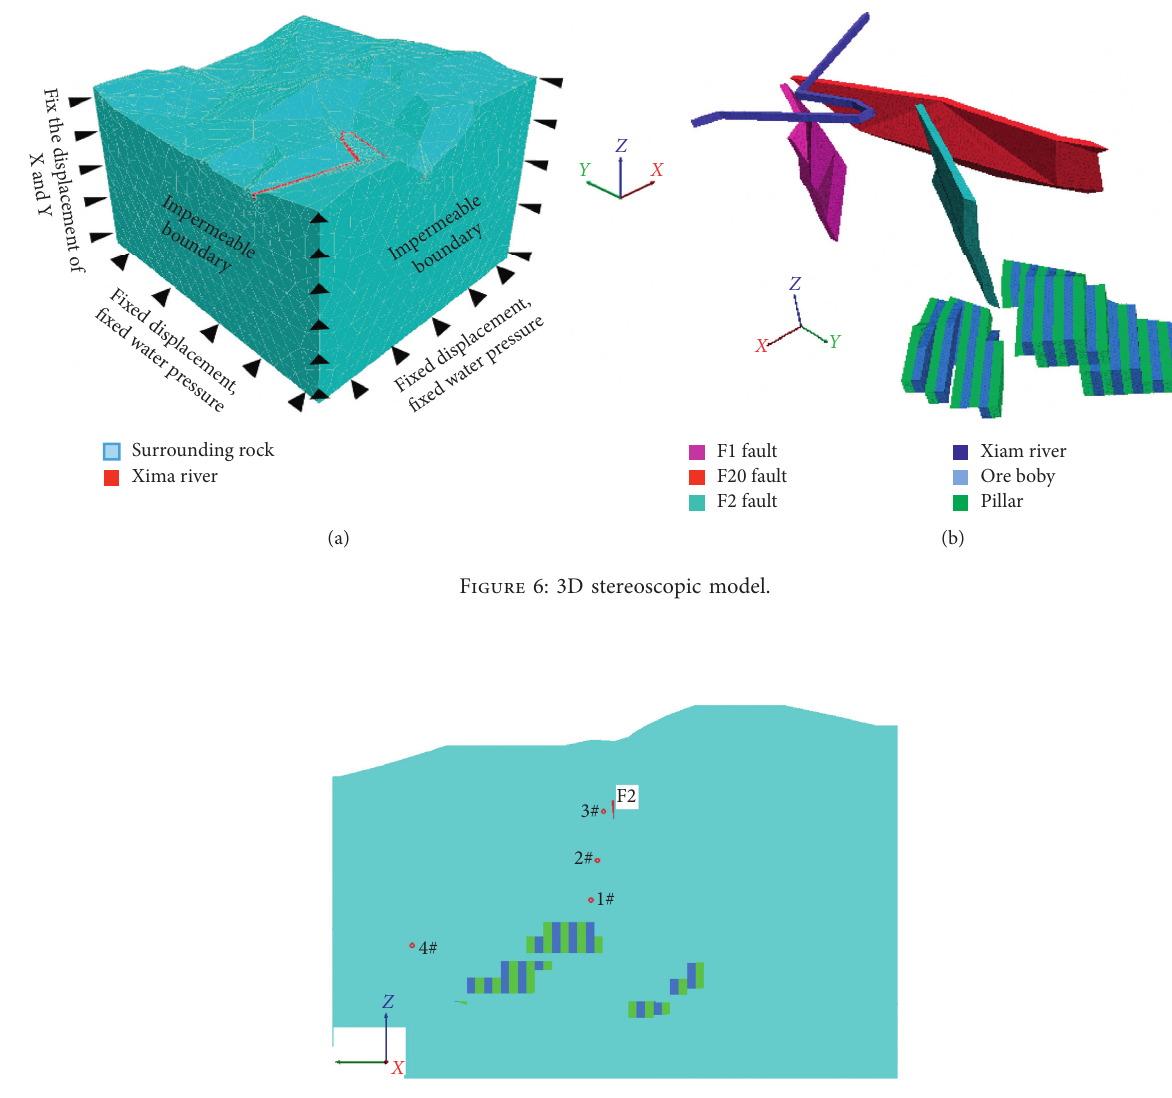
Figure 7: The layout of the monitoring